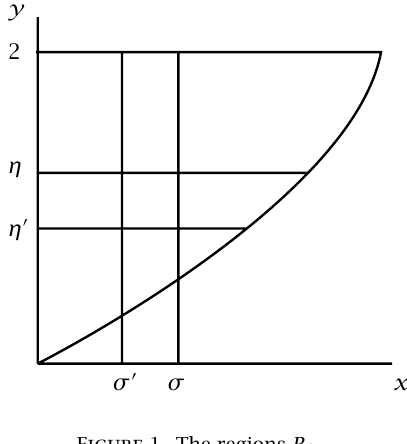
Figure 1 . The regions R i